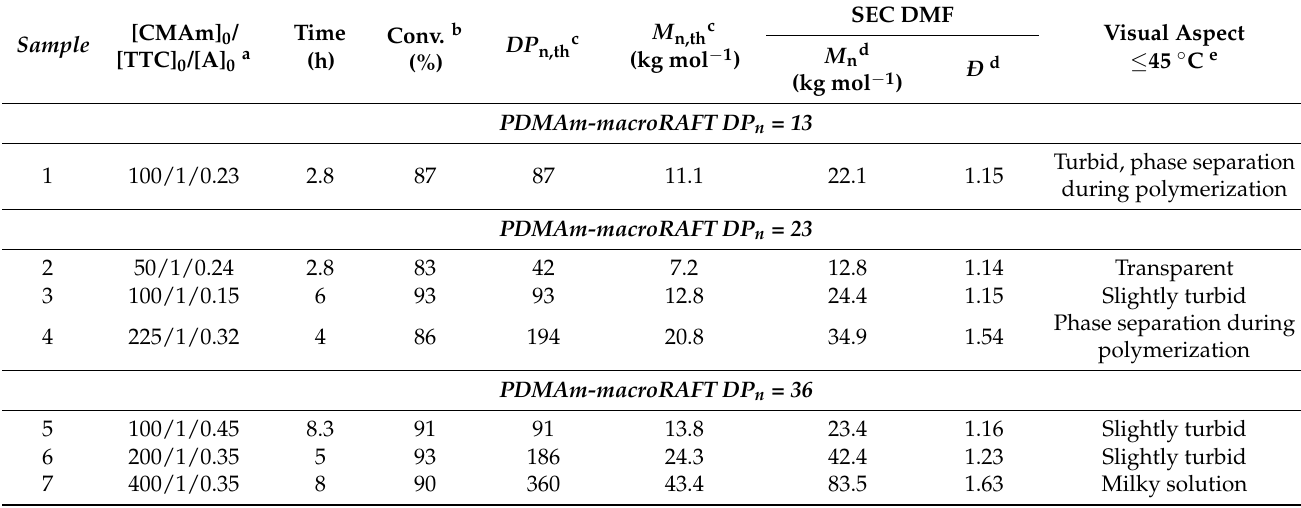
Table 1. Experimental conditions and results for the aqueous polymerizations of CMAm in the presence of various PDMAm-TTC macroRAFT agents